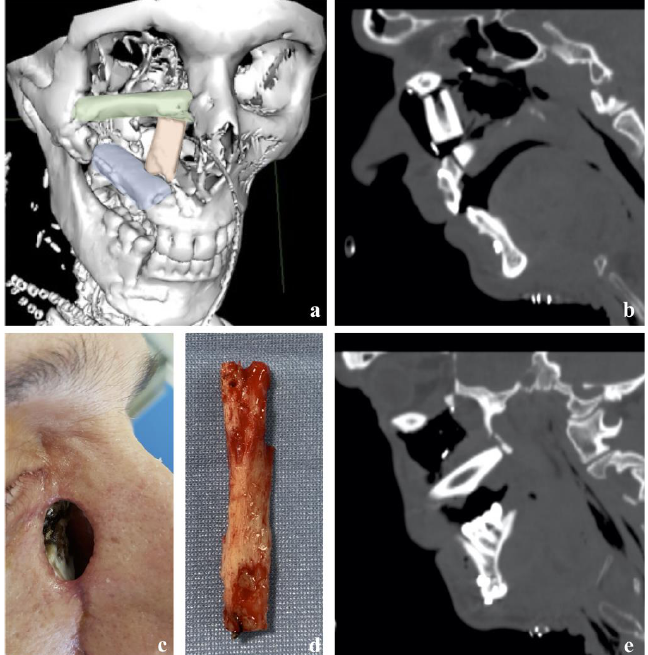
Figure 3. Partial flap failure of a free fibula flap used to reconstruct the left midface following the excision of a SCC originated from the maxillary sinus, with orbital invasion. ( a ) Three-dimensional view of the reconstruction. The pink segment, used to reconstruct the naso-maxillary buttress, was the one that subsequently had to be removed. ( b ) Post-operative CT showing the naso-maxillary segment. ( c ) Naso-cutaneous fistula determined by super-infection of the necrotic segment. ( d ) Naso-maxillary segment removed on post-operative day (POD) 23. ( e ) Post-operative CT showing the absence of the removed segment.